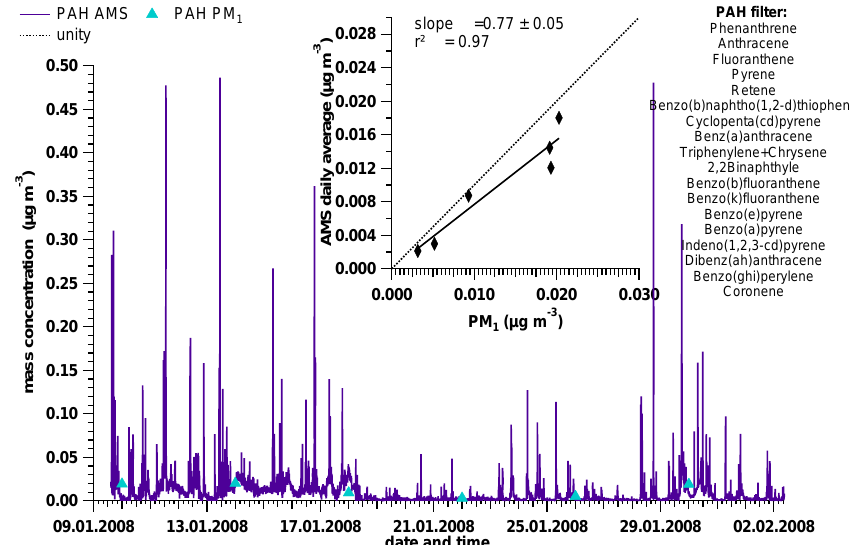
Fig. 7. AMS-PAH time series and comparison with daily PM 1